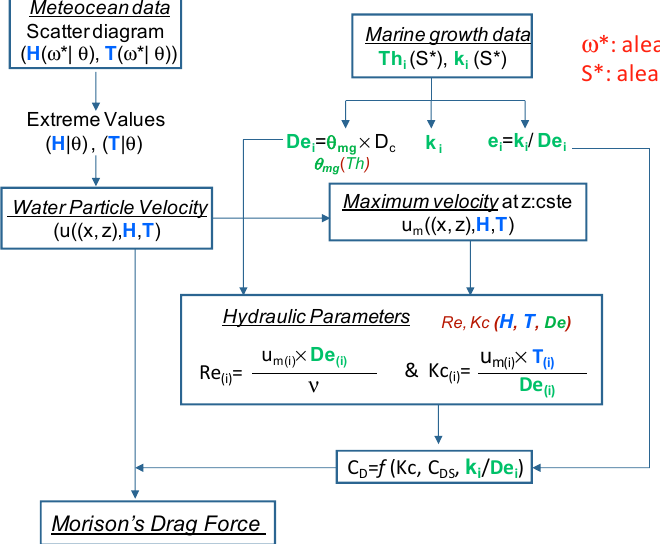
Table 2. Input parameters and random variables.